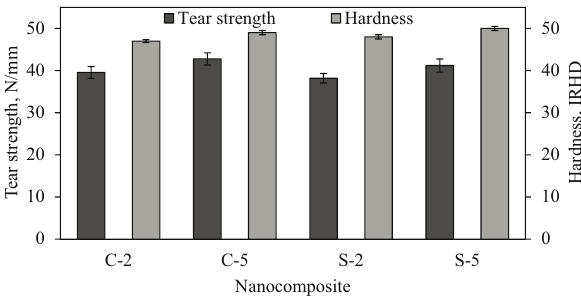
Figure 10: Tear strength and hardness of cured nanocomposites.